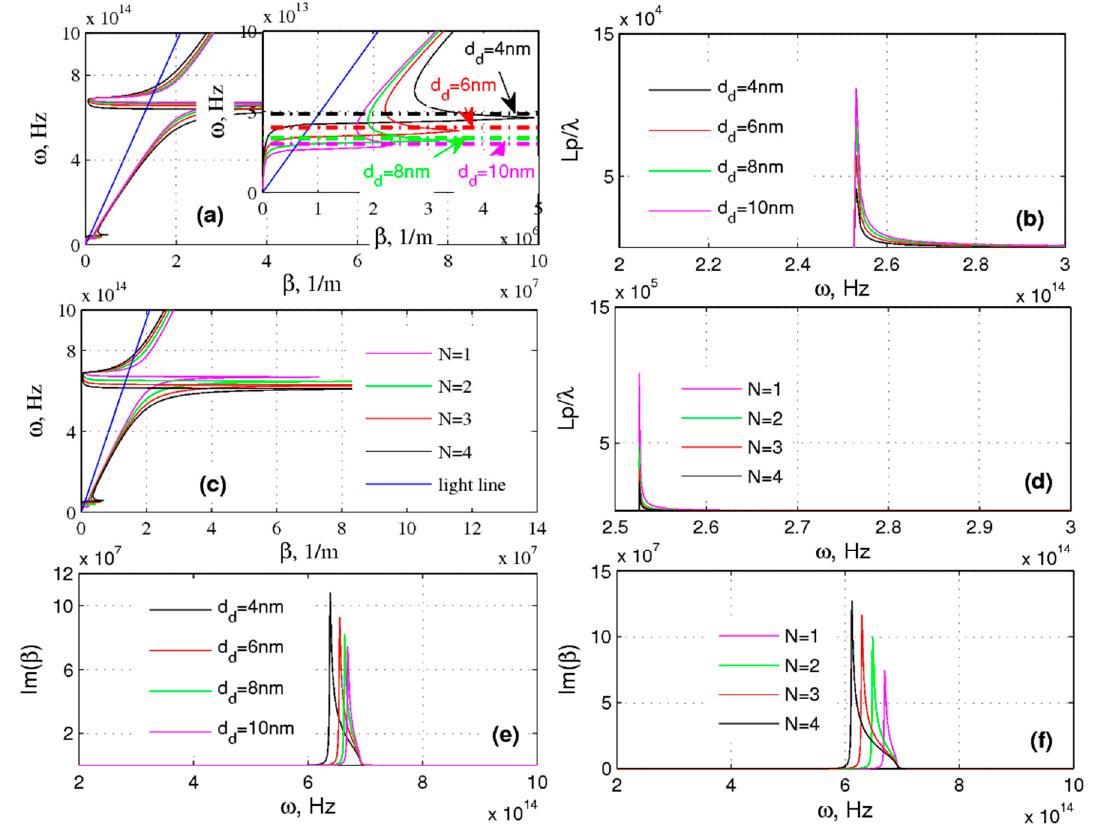
Figure 5. The dependences of dispersion of SPPs, propagation lengths, and absorption on ( a , b , e ) the thickness of dielectric d d and ( c , d , f ) number of graphene layers. Herein, the number of graphene layers, i.e., N = 1, μ = 0.5 eV in ( a , b , e ) and d d = 10 nm, μ = 0.5 eV in ( c , d , f ).